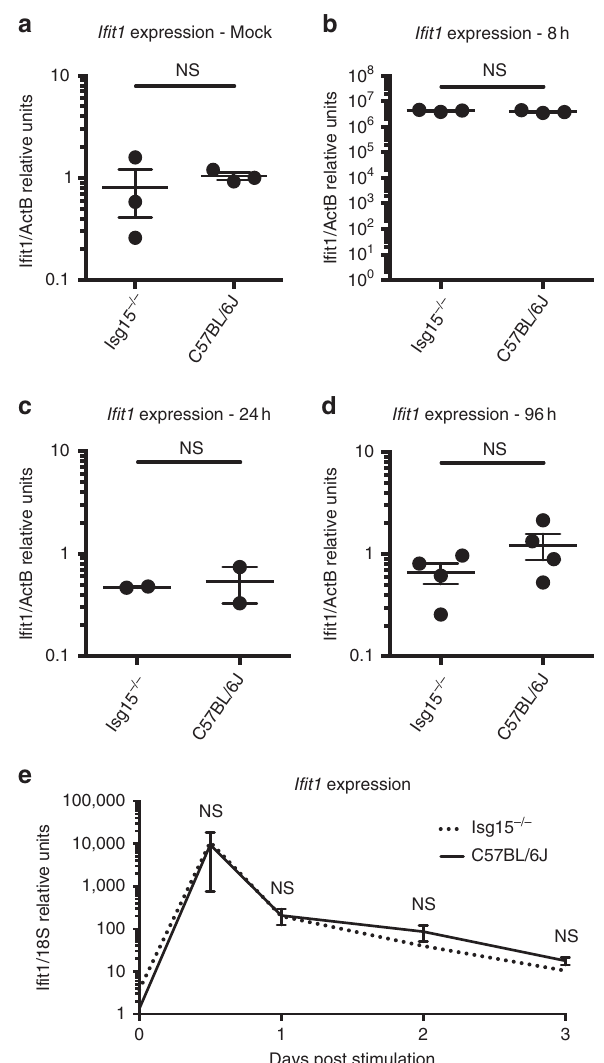
Figure 3 | Murine Isg15 deficiency does not affect the regulation of Ifit1 transcripts. ( a – d ) Age-matched Isg15 -deficient ( n ¼ 2–4 per group) or WT C57BL6/J ( n ¼ 2-4 group -1 ) mice received intraperitoneal injections of ( a ) PBS (mock) or ( b – d ) 10,000 IU type-I IFN. Animals were sacrificed at the ( b ) 8h, ( c ) 24h or ( d ) 96h post treatment and relative Ifit1 mRNA levels were determined by qPCR. ( e ) MEFs derived from Isg15 -deficient or C57BL/6J mice were mock-treated or primed with 1000IUml (cid:2) 1 type-I IFN for 12h, washed and allowed to rest for 36h. Relative mRNA levels for Ifit1 were determined by qPCR at the indicated times post-priming. e shows the combined results of three experiments. Error bars, s.d. Comparisons made with unpaired t -test. NS, not significant.